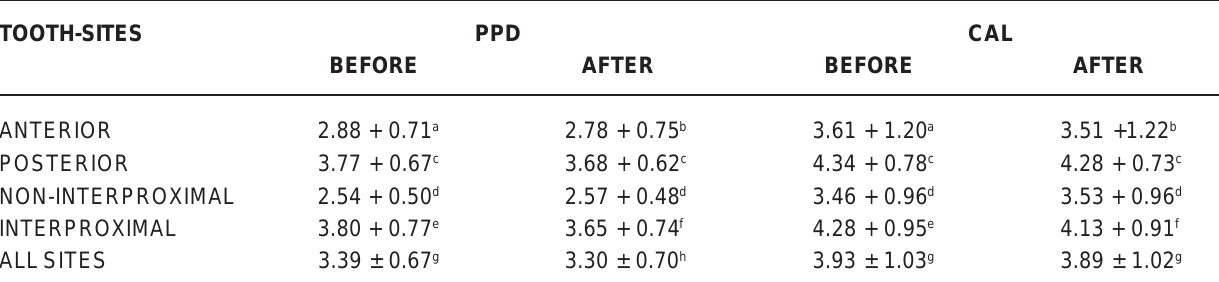
* different letters indicate statistically significant difference (P<0.05) detected with the paired t test.